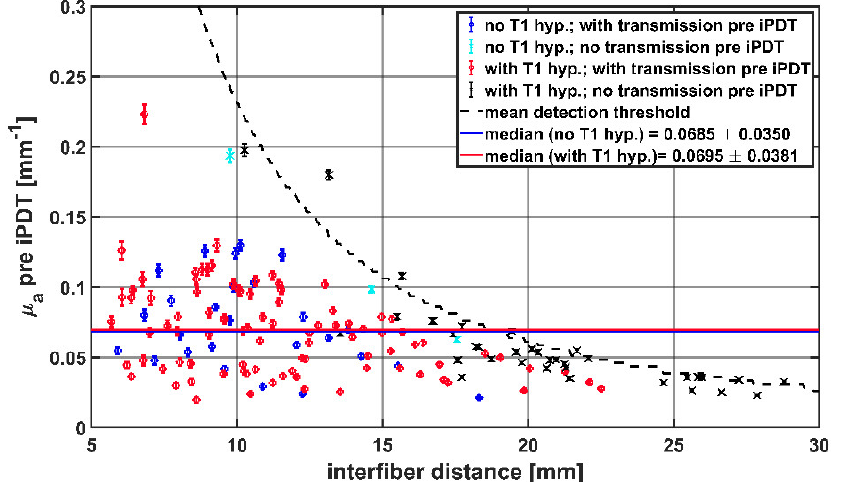
Figure 6. Calculated µ a values before start of iPDT compared to interfiber distance. The colors and symbols indicate whether transmission was detectable pre iPDT and whether intrinsic T1 hyperintensity was observed (see legend). The dashed line represents the mean detection threshold of the SOM setup.